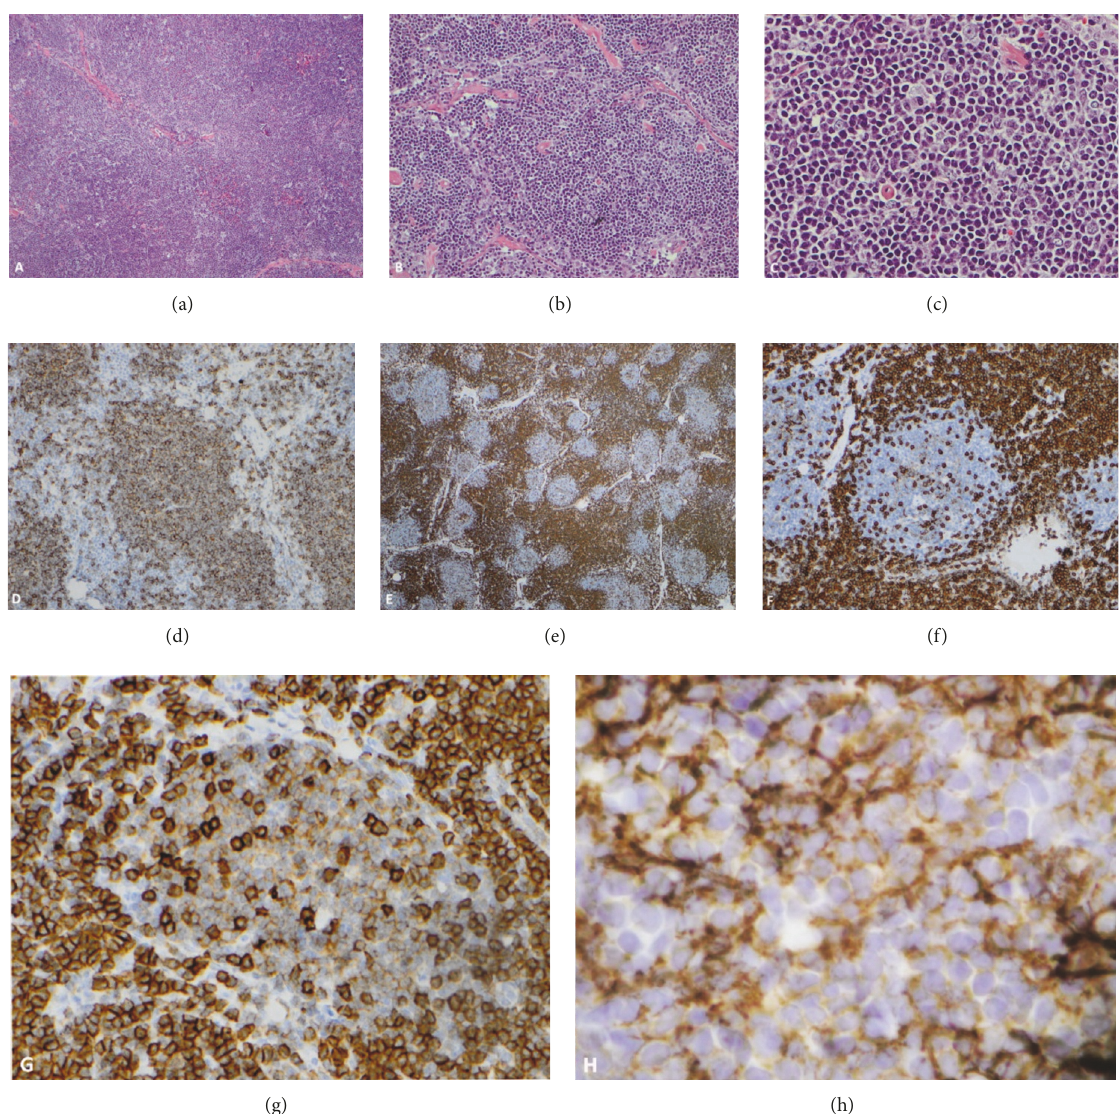
Figure 1: Composite chroniclymphocytic leukemia/small lymphocytic lymphoma (CLL/SLL) and T-prolymphocytic leukemia (T-PLL).This lymph node shows partial effacement of the architectureby a vaguely nodular/follicular proliferation of small-to-medium-sized lymphocytes surrounded by a dense infiltrate of small-to-intermediate-size lymphocytes. Hematoxylin and eosin stain (a–c). Immunohistochemistry shows that the nodular/follicular areas react with the B-cell marker CD20 (d), whereas the interfollicular areas are highlighted with the T-cell marker CD3 (e, f). Note that the follicular areas are also faintly positive with CD5 (g) and dimly positive with CD23 (h), supporting CLL/SLL (h). This distribution of CLL/SLL centered on follicular dendritic cell meshworks highlighted with CD23 is extremely unusual and supports the so-called follicular pattern of